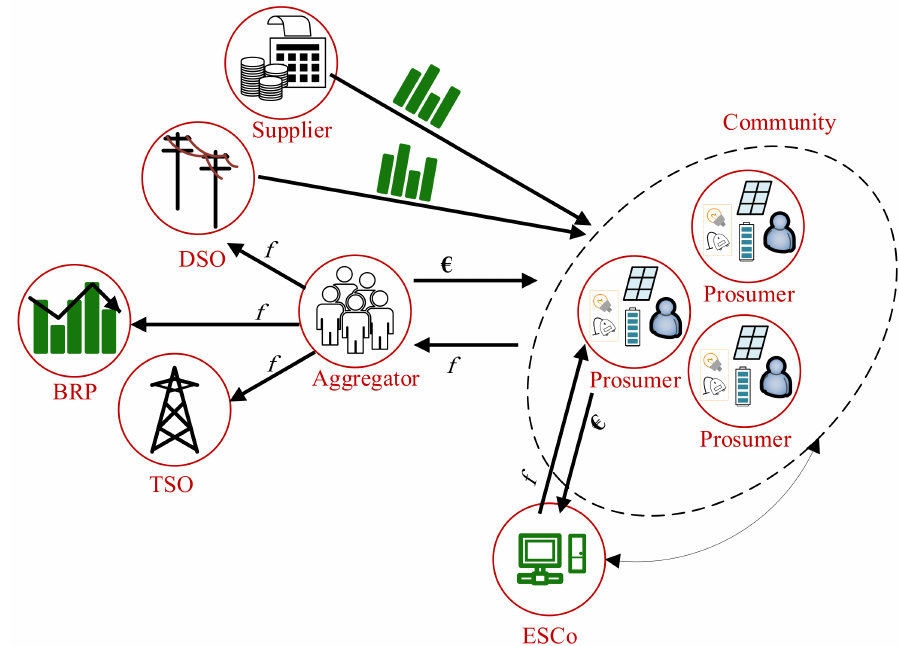
Figure 5. A widely discussed structure for LEMs and the roles of various